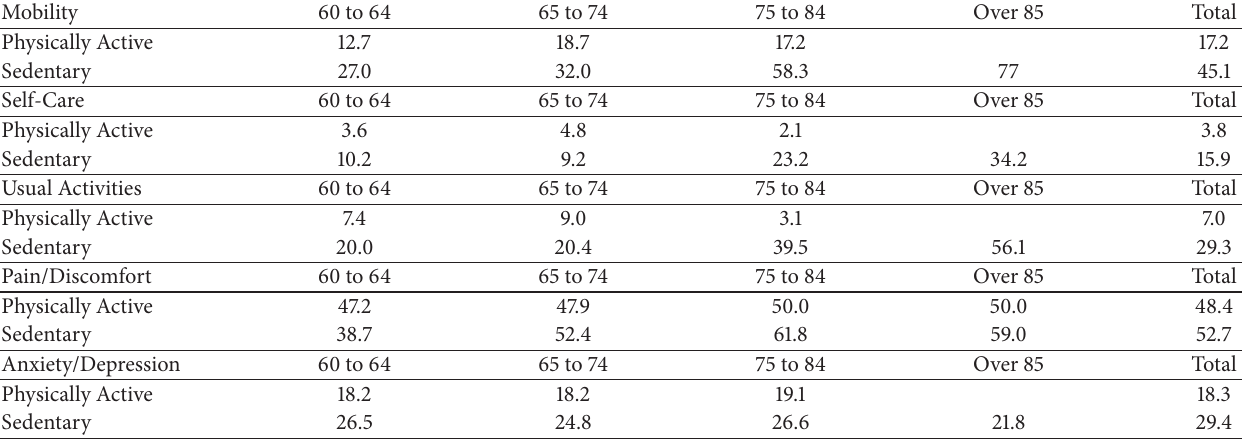
Table 2: Percentage of men with problems in EQ-5D dimensions according to age and physical activity level.